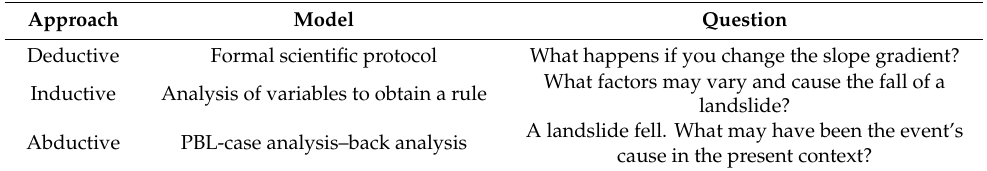
Table 1. Examples of open questions regarding the same subject, formulated with di ff erent educational approaches